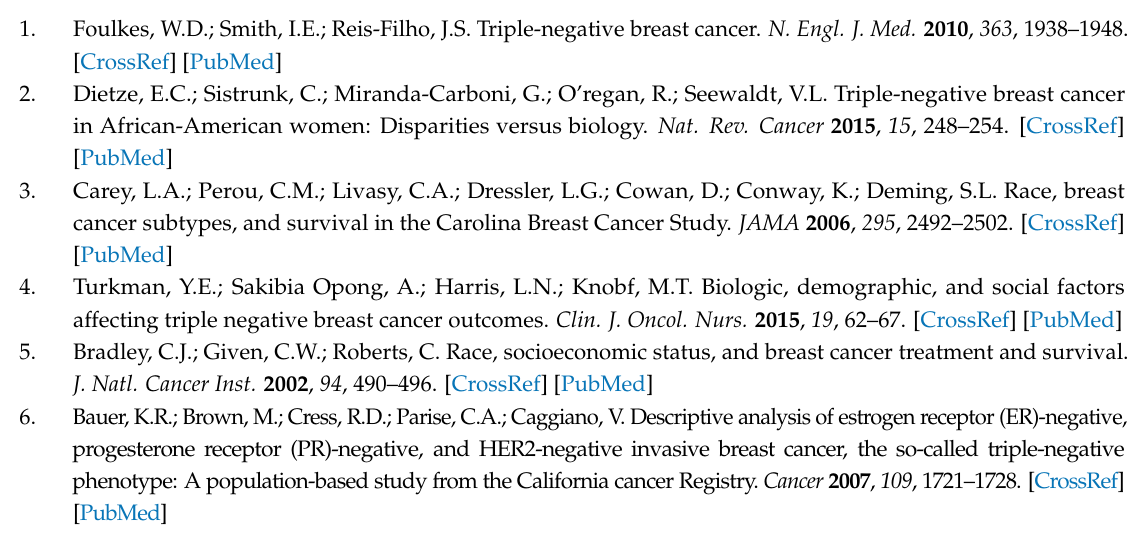
Table SA: List of significantly differentially expressed genes showing evidence of association with TNBC at p < 0.05 among the three patient groups in women with premenopausal status. Table SB: List of significantly differentially expressed genes showing evidence of association with TNBC at p < 0.05 among the three patient groups in women with postmenopausal status. Table S1: List of significantly differentially expressed genes showing evidence of association between TNBC and obesity or overweight status in women with premenopausal status. Also shown in this table is a list of significantly differentially expressed genes distinguishing obese from non-obese women. Table S2: List of significantly differentially expressed genes showing evidence of the association between TNBC and obesity or overweight status in women with postmenopausal status. Also shown in this table is a list of significantly differentially expressed genes distinguishing obese from non-obese